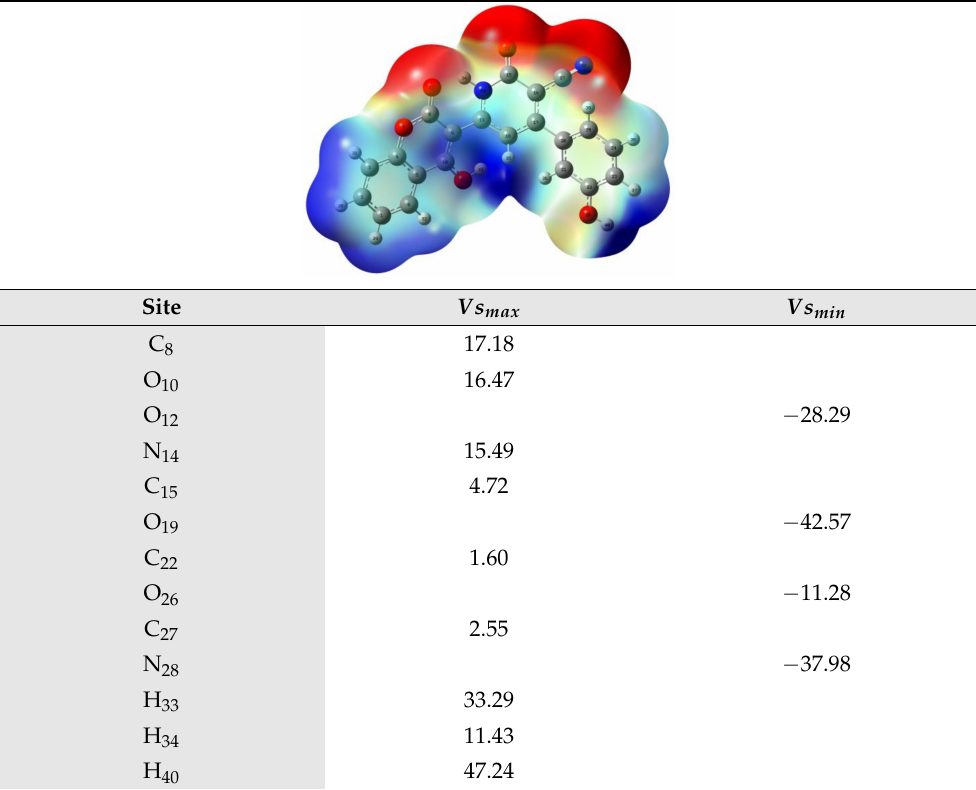
Table 3. Computed maximum and minimum potential values (in kcal · mol − 1 ) of the product at B3LYP/6-31+G(d).